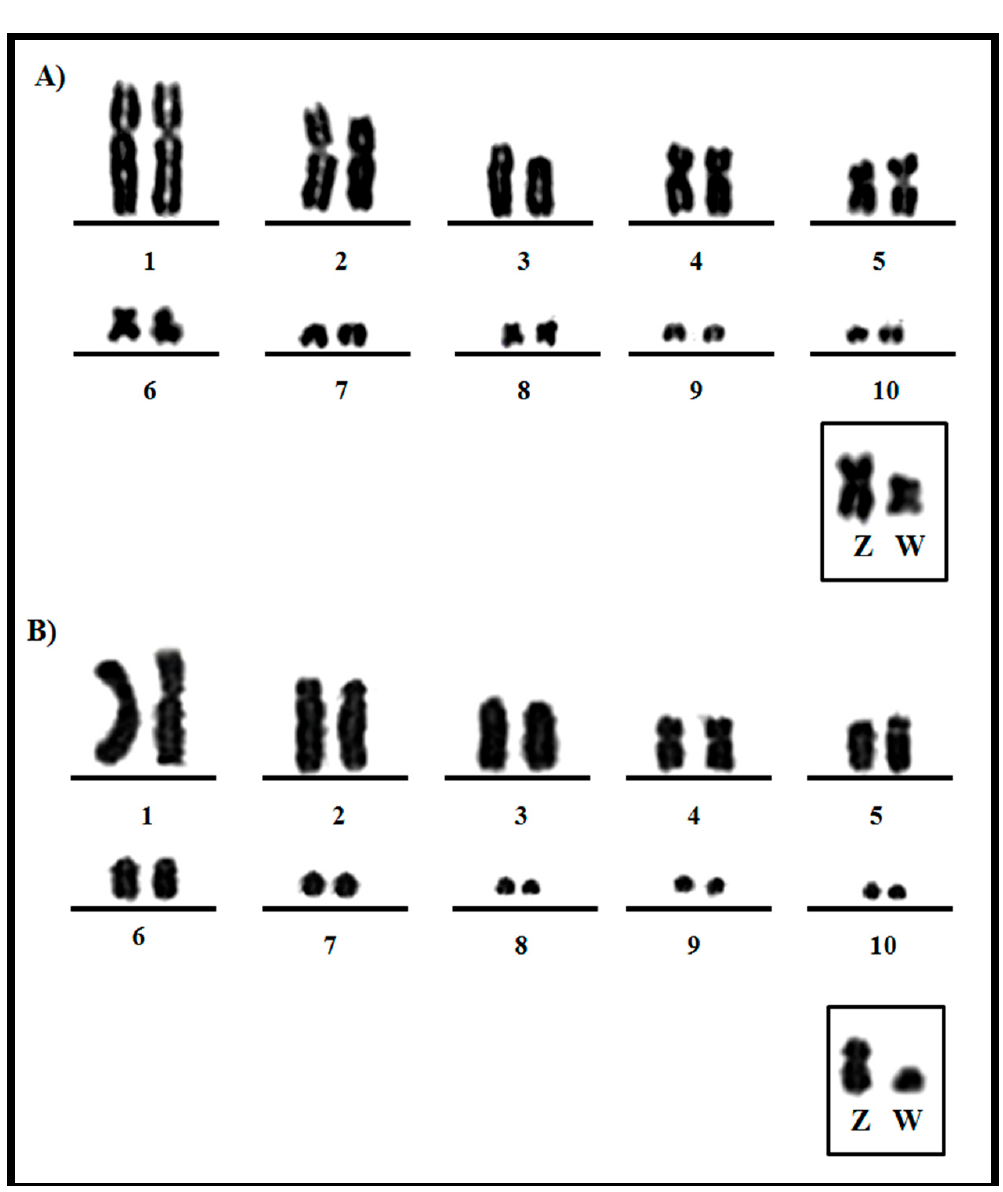
Figure 1. Partial karyotypes (pair 1–10 and ZW) of ( A ) Aramides cajaneus (2n = 78) and ( B ) Psophia viridis (2n = 80) (from pair 11 on, chromosomes correspond to indistinguishable microchromosomes, with the same size and morphology; for this reason, only the macrochromosomes are